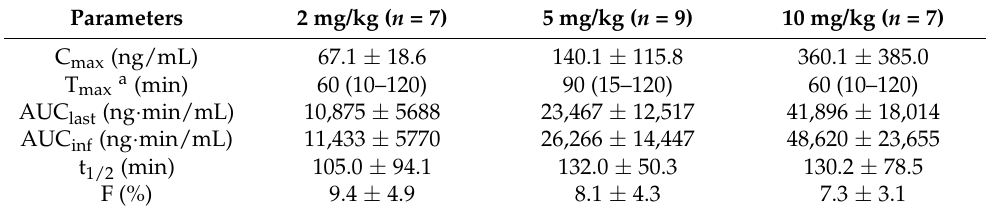
Table 3. Toxicokinetic parameters of β -amanitin in male ICR mice after oral administration of three doses (mean ± SD).